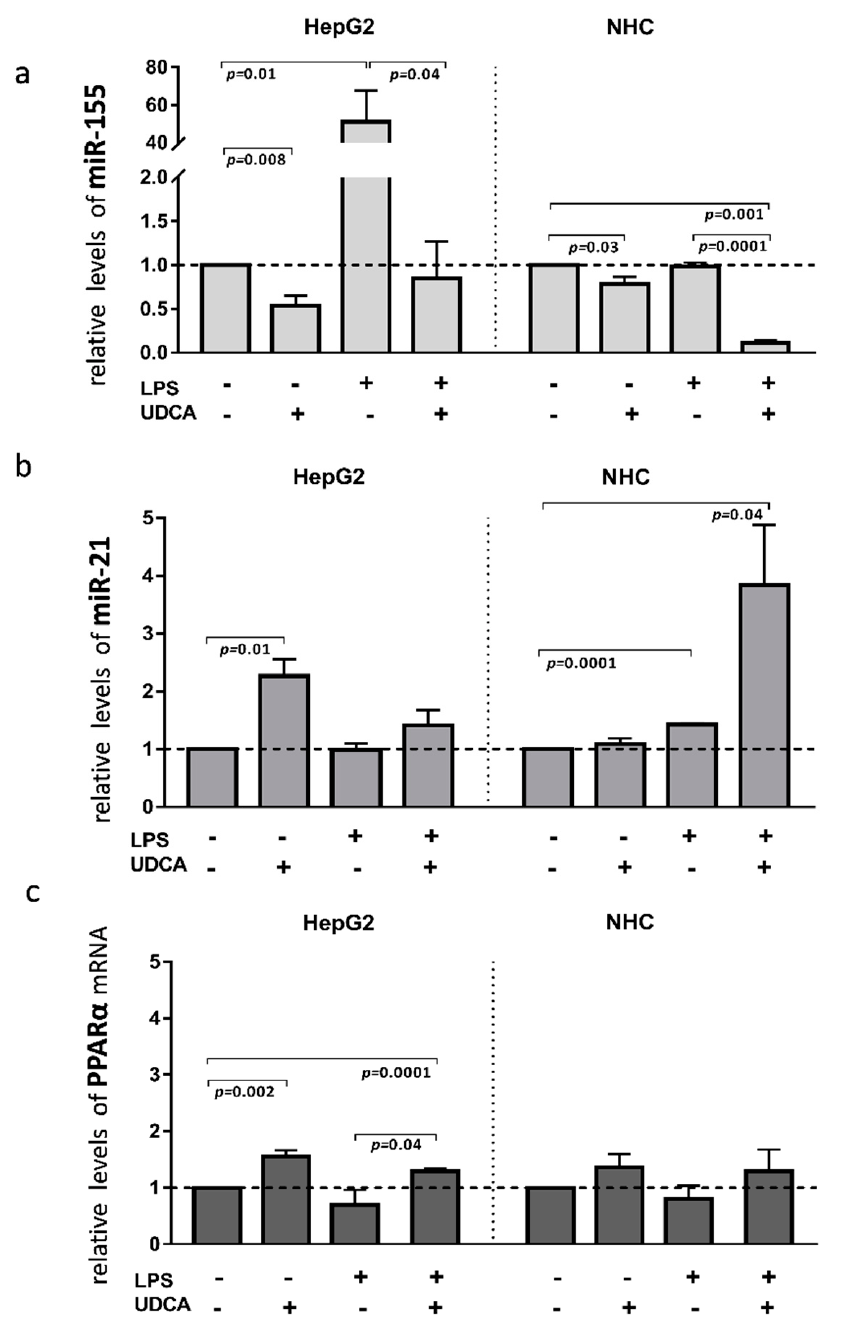
Figure 4. The effect of lipopolysaccharide (LPS) and/or ursodeoxycholic acid (UDCA) exposure in human hepatocarcinoma (HepG2) and normal human cholangiocyte (NHC) cell lines. LPS stimuli enhanced miR-155 ( a ) in HepG2 cells and miR-21 ( b ) in NHC cells. MiR-155 was enhanced after the incubation of HepG2 cells with LPS, whereas, in NHC, the expression of miR-21 was induced by LPS stimuli. UDCA reduced both the baseline and LPS-induced miR-155 expression in HepG2 cells, which was accompanied by the upregulation of PPAR α . In NHC cells, UDCA enhanced the expression of miR-21 but did not affect PPAR α expression ( c ). Bars indicate the mean ± SEM. The statistical analysis was performed using